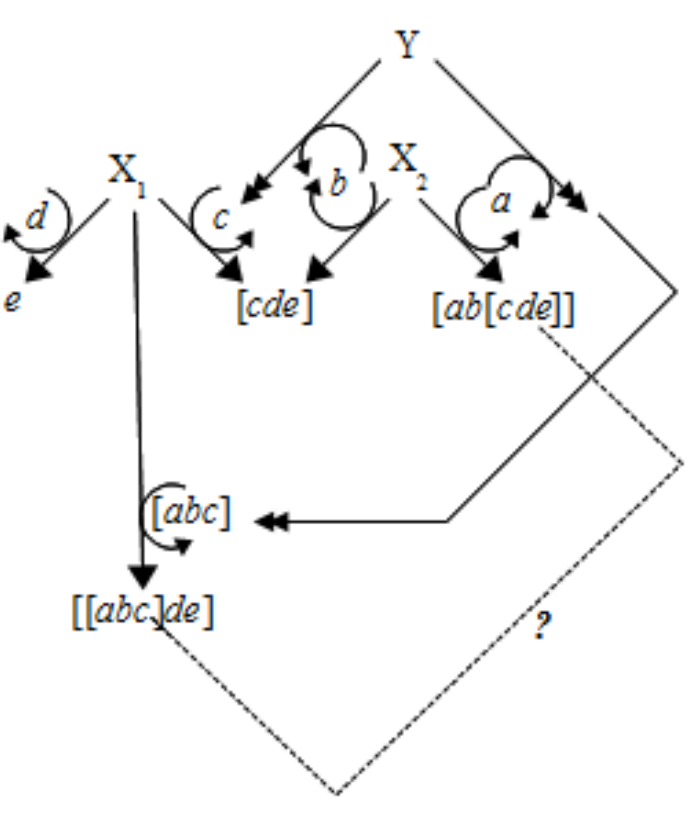
Figure 3. Para-associative